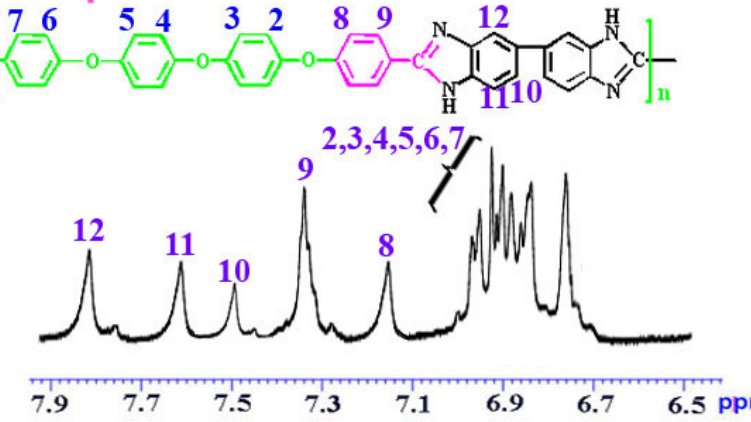
Fig. 2. 1 H-NMR (500 MHz) spectrum of PBI in DMSO-d6 at